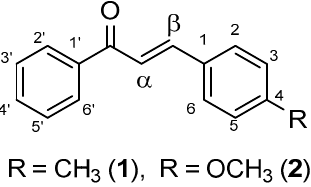
Figure 1. Structure and numbering of the investigated chalcones ( 1 and 2 ).